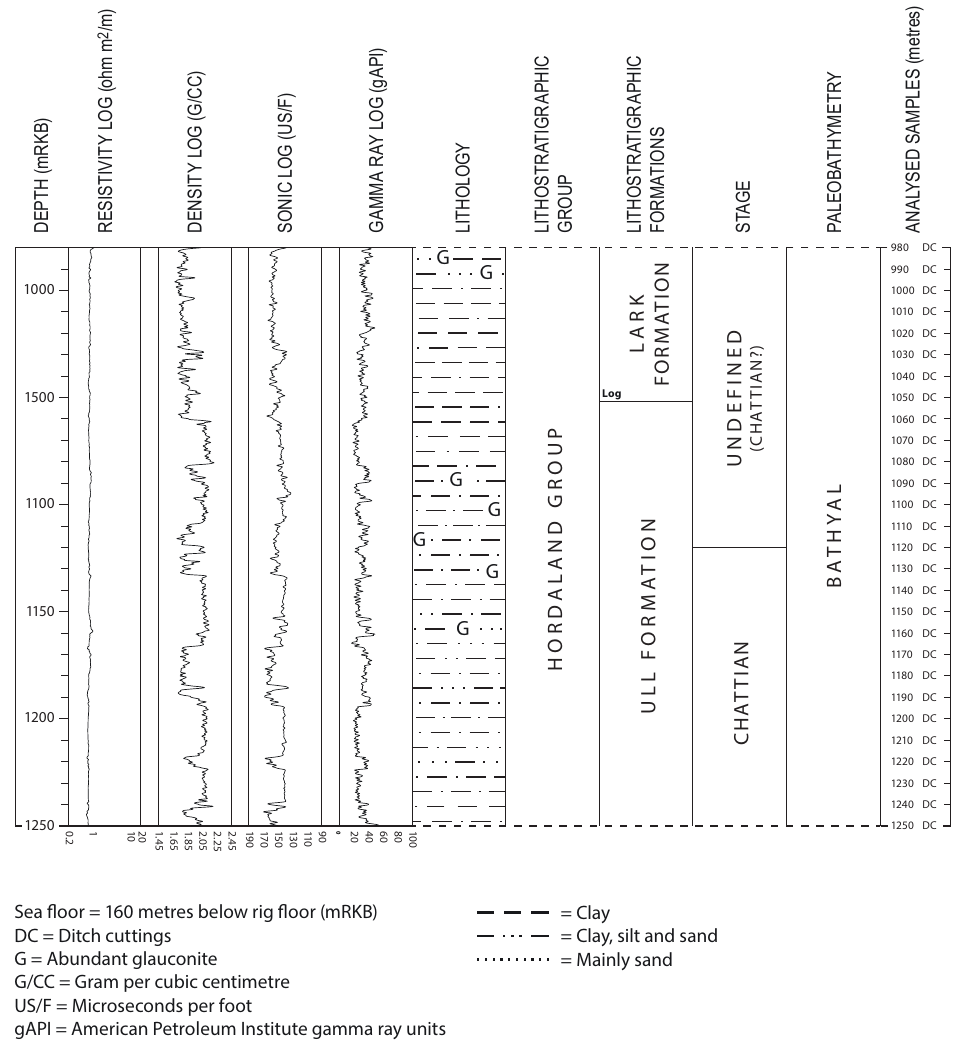
= Clay = Clay, silt and sand = Mainly sand